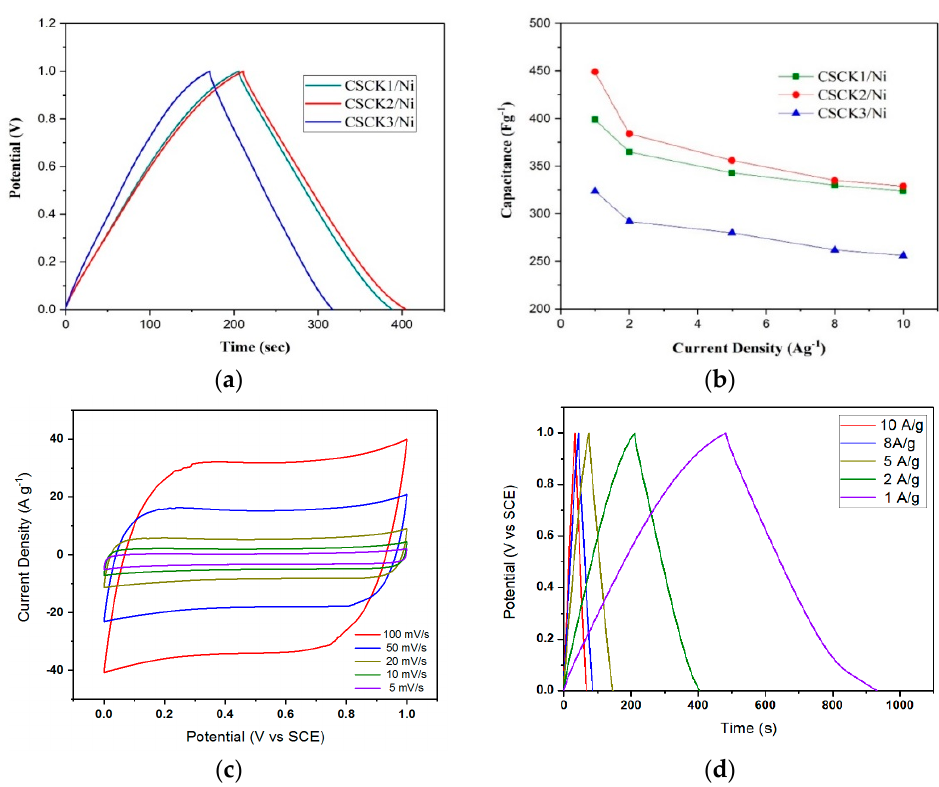
Figure 4. Electrochemical characteristics of CSCKs/Ni electrodes in 6 M LiNO 3 aqueous electrolyte in a three-electrode system: ( a ) GCD curves at 2 A g − 1 for CSCKs/Ni electrodes; ( b ) specific capacitances of CSCKs/Ni electrodes at various current densities; ( c ) CV curves of CSCK2/Ni electrode at various scan rates; and ( d ) GCD curves of CSCK2/Ni electrode at various current densities.